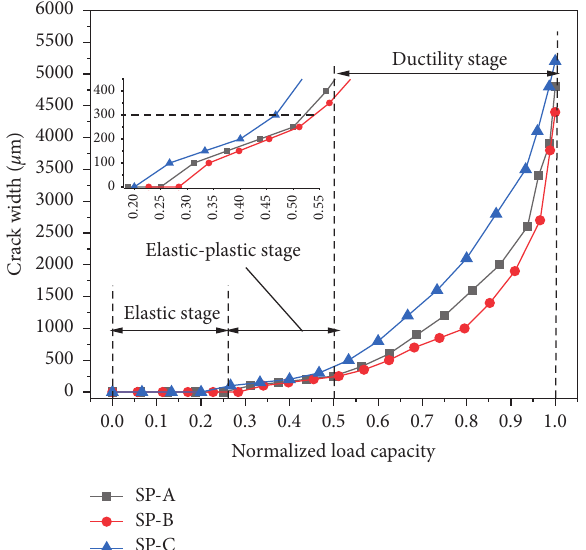
Figure 5: Crack width and normalized loading